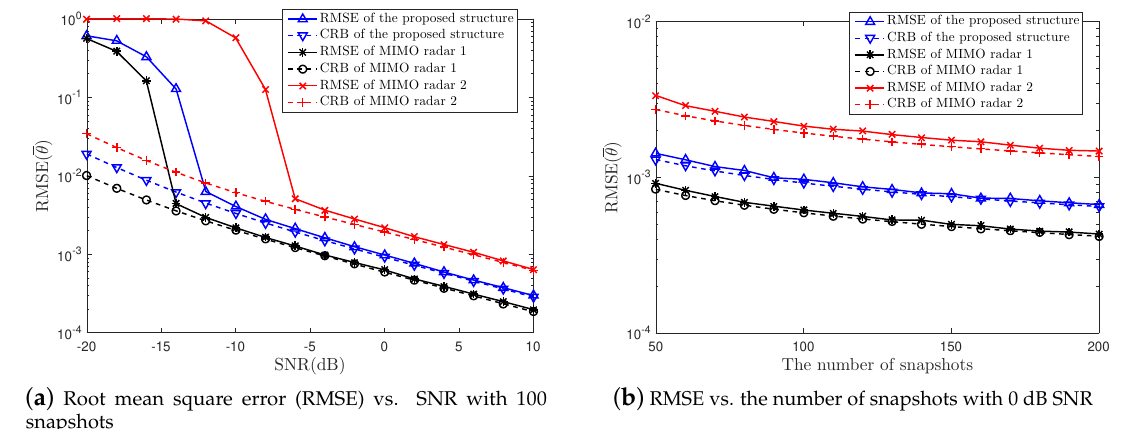
( b ) RMSE vs. the number of snapshots with 0 dB SNR Figure 3. RMSE vs. ( a ) SNR and ( b ) the number of